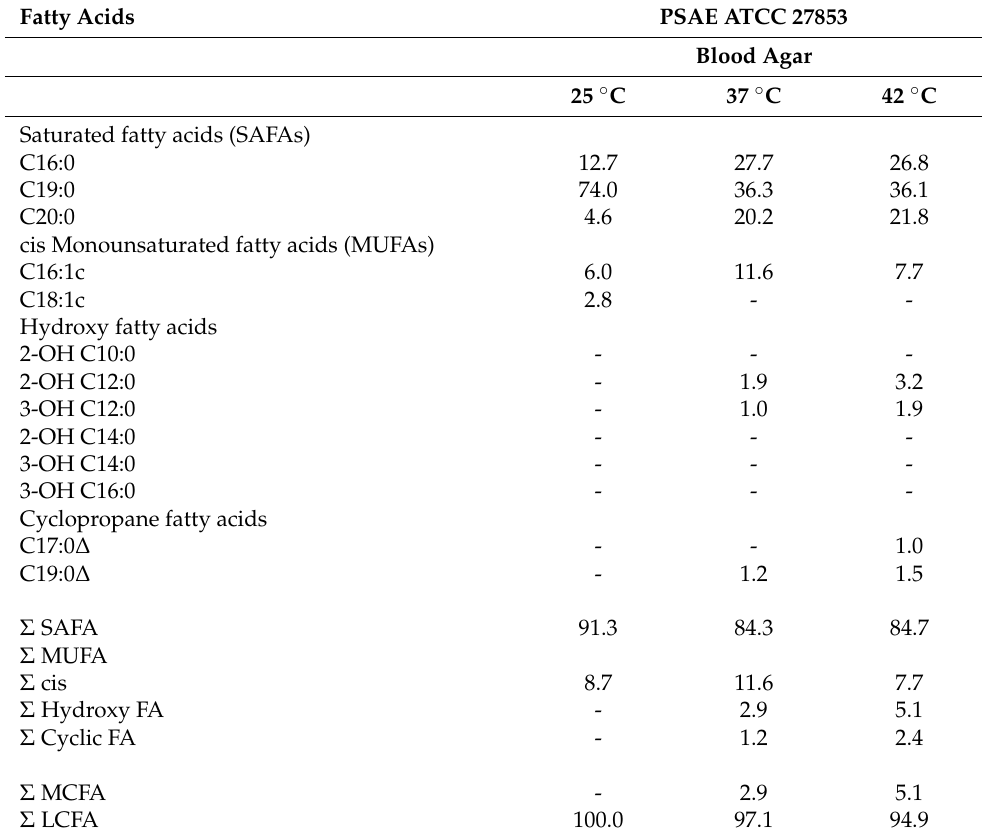
Table 4. Fatty acid proportions (% of total fatty acids) of P. aeruginosa ATCC 27853 bacteria grown at 25 ◦ C, 37 ◦ C and 42 ◦ C using blood agar media. The fatty acid extraction was made in triplicates from cultivates on the 1st, the 3rd or the 5th day following inoculation. The relative standard deviation is less than